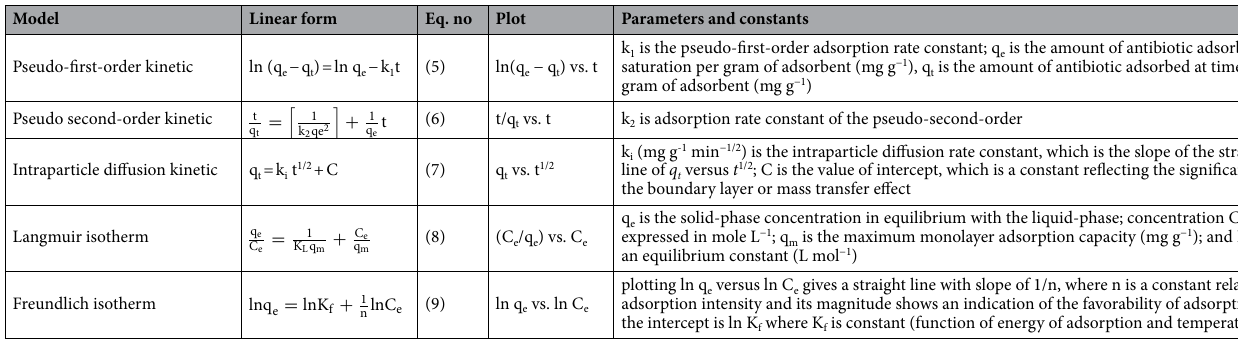
Table 1. Kinetics and isotherms models of adsorption